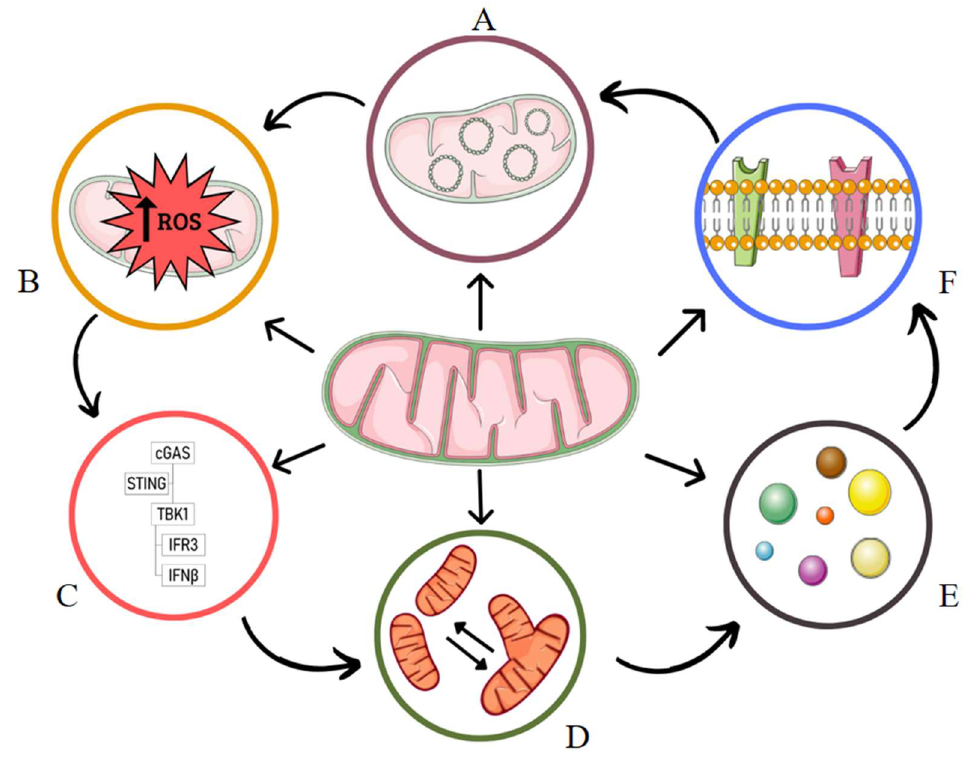
Figure 1. Mitochondrial pathways in the immune response. A: Mitochondrial DNA. B: ROS accumulation. C: cGAS-STING.D: Mitochondrial dynamics. E: Inflammassomes. F: TLR receptors.